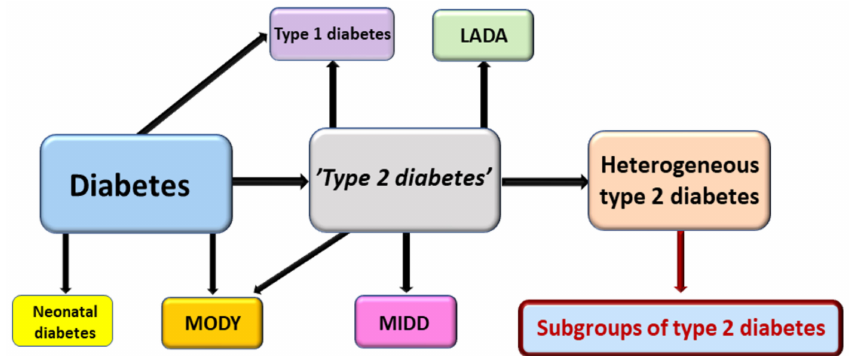
Figure 3. Identification of the subgroups of type 2 diabetes. Diabetes has several subtypes which need to be excluded when analyzing the subgroups of type 2 diabetes. Neonatal diabetes, maturity onset diabetes of the young (MODY), and type 1 diabetes are diagnosed at young age; latent autoimmune diabetes in adults (LADA) and mitochondrial diabetes and deafness (MIDD) in middle or elderly age. When all subtypes of diabetes have been excluded we have heterogeneous type 2 diabetes, and the subgroups can be